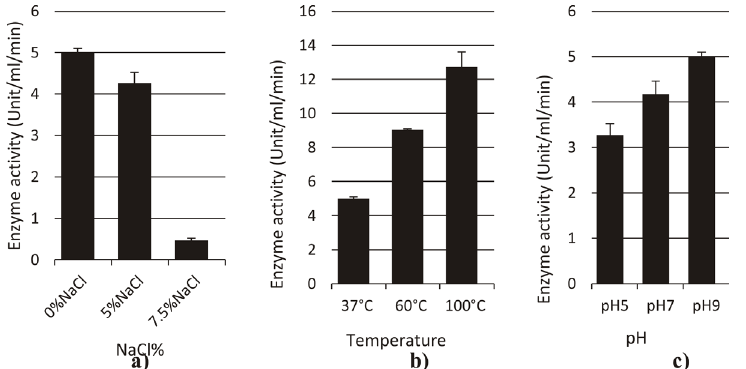
Fig. 7. Effect of different factors ( a :NaCl%, b : Temperature, c : pH) on activity of L-asparaginase enzyme from Enterobacter